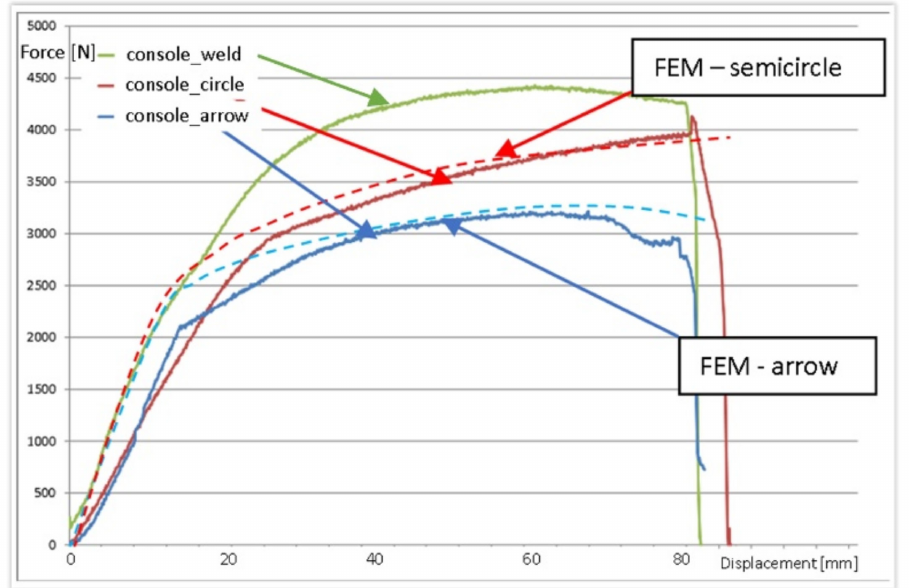
Figure 19. Comparison of forces obtained during loading of the console for selected cases of experi- mental tests and FEM simulations with a profile cross-section of 40 mm × 40 mm: semicircular lock; arrow lock; welded